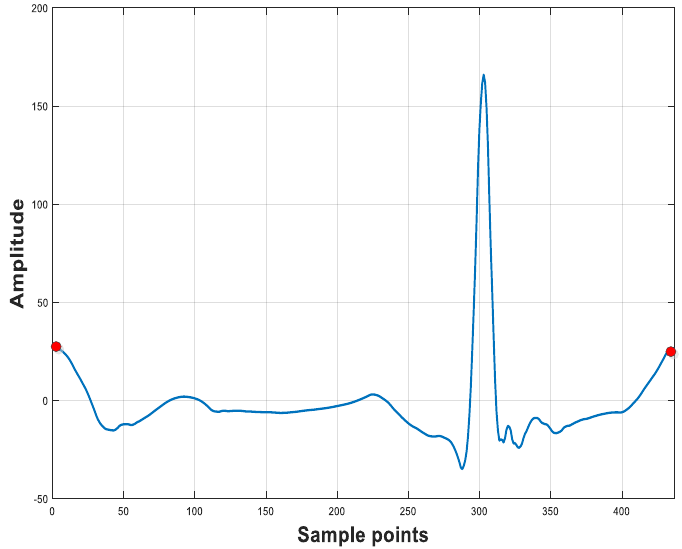
Figure 3. An extracted heart beat taking T as the delimiters.